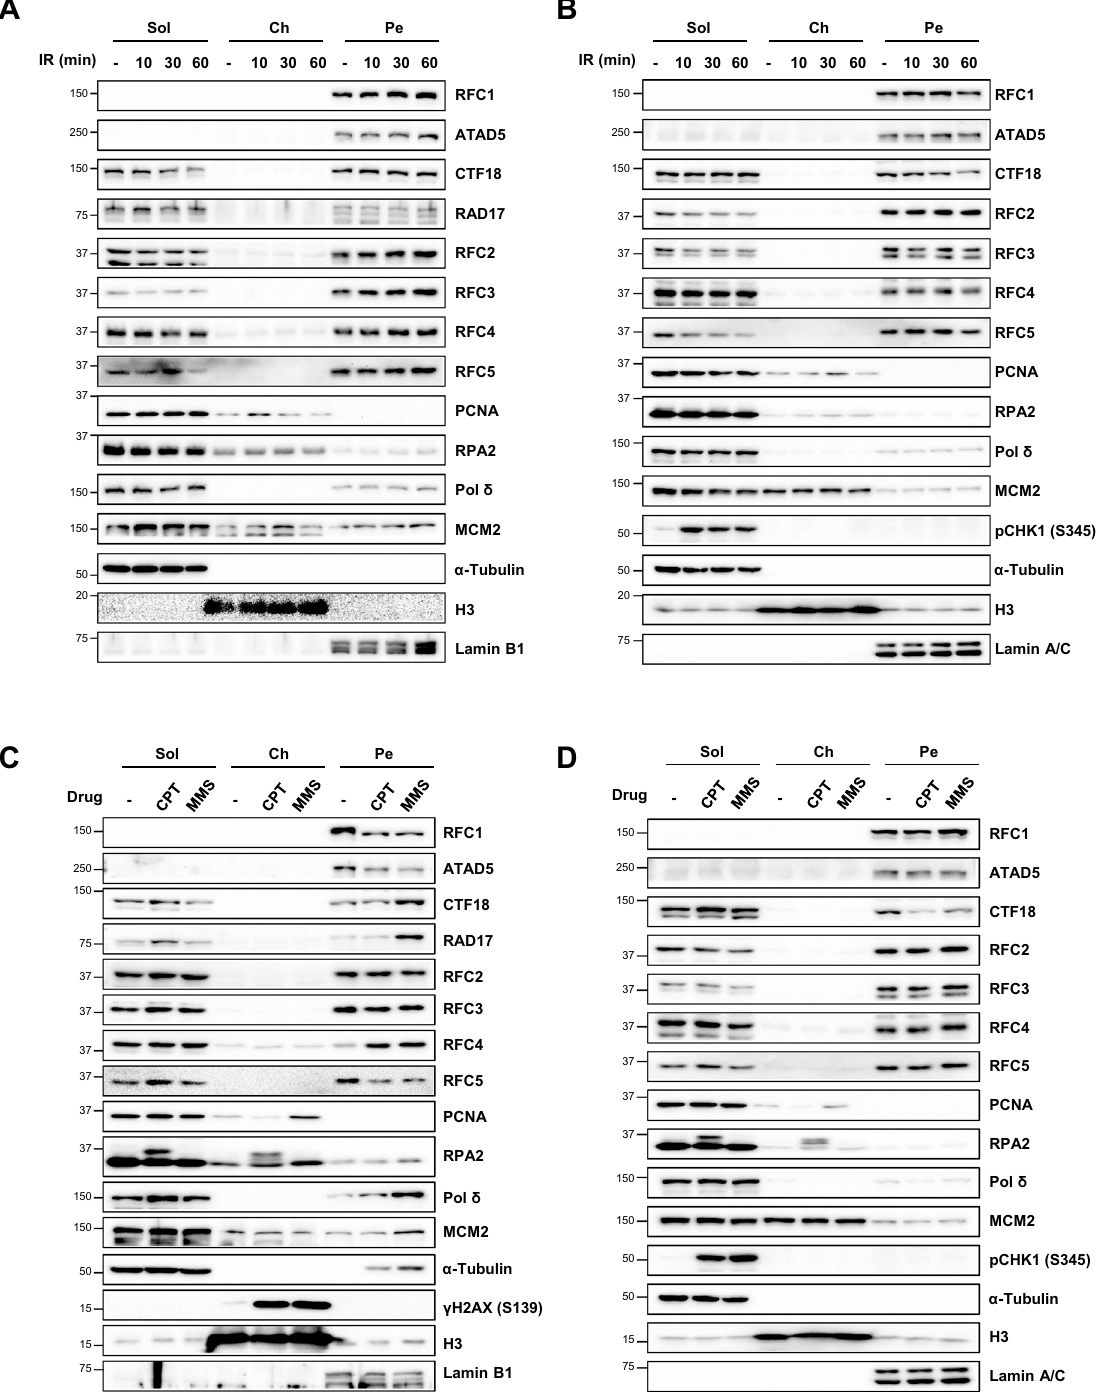
Figure 3. The fractionation profile of RFC/RLC proteins is not affected by DNA damage. ( A , B ) HeLa ( A ) or HEK293T ( B ) cells were irradiated with 10 Gy (Gy) X-ray and recovered for indicated times. ( C , D ) HeLa ( C ) or HEK293T ( D ) cells were treated 2 μM camptothecin (CPT) or 0.02% methyl methanesulfonate (MMS) for 2 h. ( A – D ) After treatment, cells were fractionated and each fraction was subjected to immunoblotting. ( A – D ) Uncropped blot images are presented in Supplementary Fig.